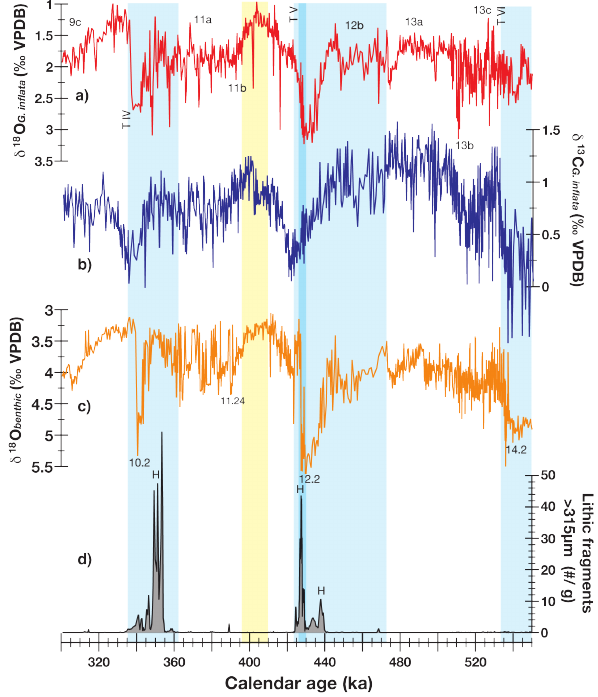
Fig. 5. Records for core MD03-2699, the nearshore site off Por- tugal: (a) G. inflata δ 18 O (‰VPDB; red), (b) G. inflata δ 13 C (‰VPDB; blue), (c) benthic δ 18 O (‰VPDB; orange), and (d) lithics concentration (#/g; black). Light blue bars mark glacial MIS 10, 12 and 14; dark blue bar the Heinrich-type event at the end of MIS 12; and the yellow bar the MIS 11 sea level highstand. Sub- stages (e.g. 11c) are indicated on the G. inflata δ 18 O record (a) and isotopic events (e.g. 10.4) on the benthic δ 18 O record (c). T IV, V and VI refer to Terminations VI, V and VI. H indicates Heinrich- type ice-rafting